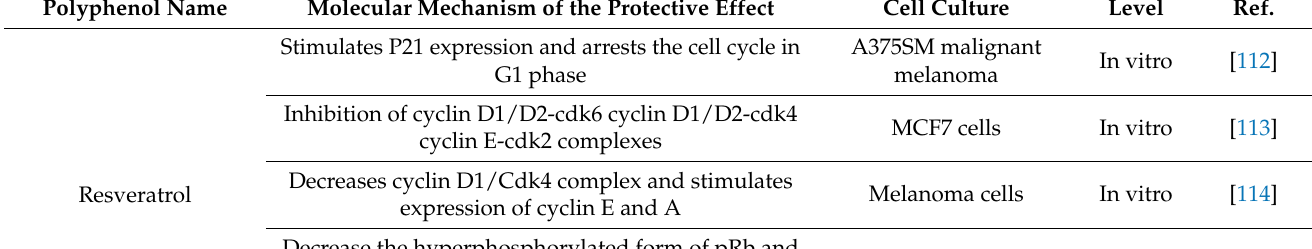
Table 13. Effect of the polyphenol content of grape marc (grape seeds and skins) on the cell cycle. Polyphenol